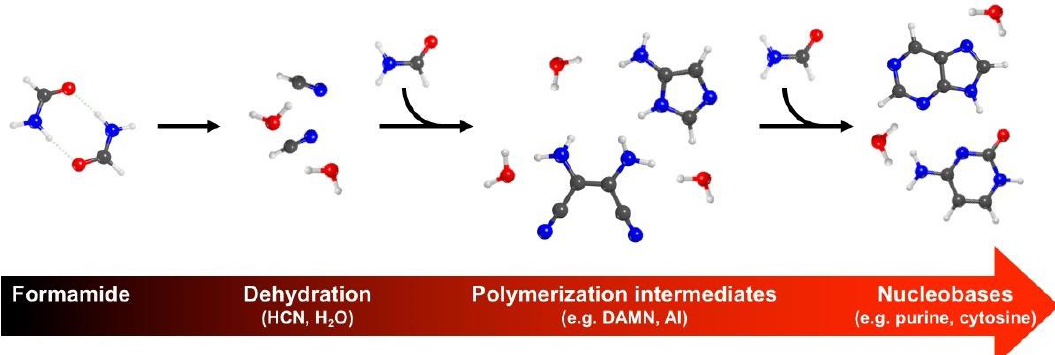
Figure 1. Schematic reaction path from formamide to form nucleobases, via its dehydration to HCN and H 2 O and its subsequent polymerization reaction through stable intermediates (examples represented: diaminomaleonitrile, DAMN; and 5-aminoimidazole, AI) to yield nucleobases (examples represented: purine and cytosine). Atoms color code: white, H; gray, C; blue, N; and red, O.